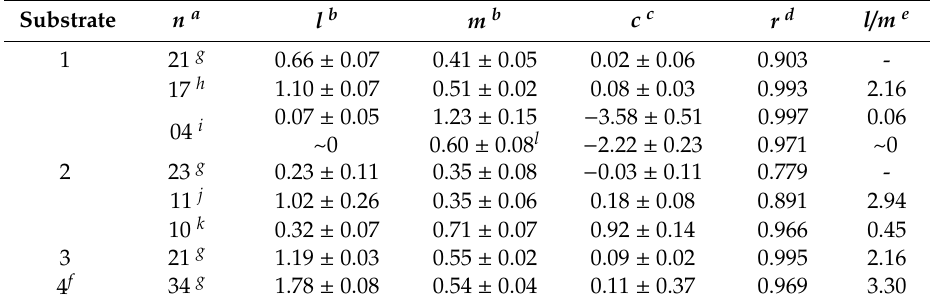
Table 4. Correlation of the rate constants for the solvolyses of 1 , 2 , 3 , and 4 , using the extended G–W Equation